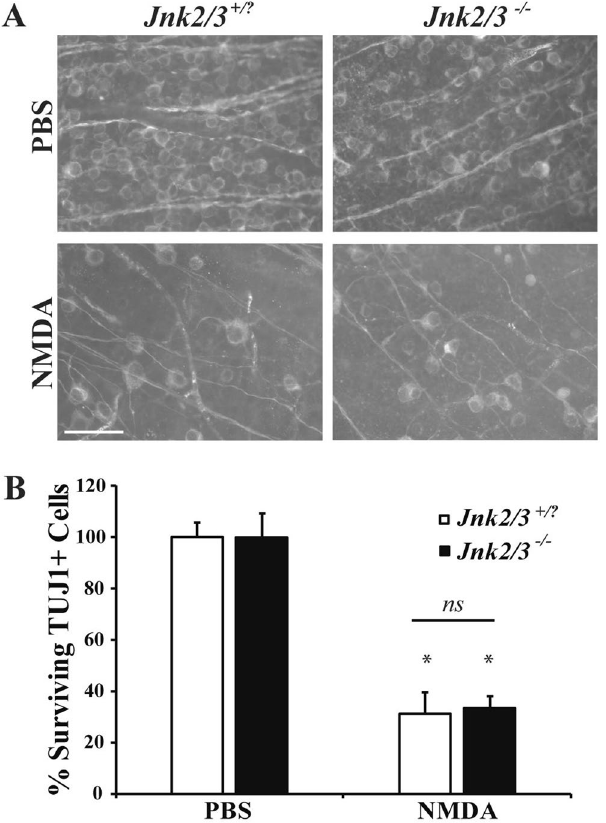
Figure 6. Jnk2 − / − Jnk3 − / − nulls do not have attenuated RGC loss after excitotoxic injury. ( A ) Representative images showing TUJ1 immunolabeled cells in the GCL of Jnk2Jnk3 deficient mice 7 days after intravitreal NMDA or PBS injection, revealing significant RGC loss in both wildtype ( Jnk2 + /? Jnk3 + /? ) and Jnk2 − / − Jnk3 − / − deficient mice after NMDA insult (n = 4 for PBS WT, n = 4 for NMDA WT, n = 3 for PBS Jnk2 − / − Jnk3 − / − , n = 3 for NMDA Jnk2 − / − Jnk3 − / − ). ( B ) Quantification of TUJ1 + RGCs confirmed that Jnk2 − / − Jnk3 − / − deficient mice had a similar loss of RGCs compared to wildtype mice 7d after NMDA injection ( * p ≤ 0.001 for comparison between PBS and NMDA; p ≥ 0.9769 comparing WT to Jnk2 − / − Jnk3 − / − NMDA; ns between genotypes; two-way ANOVA, Tukey’s multiple comparisons test). Scale bar: 50 μ